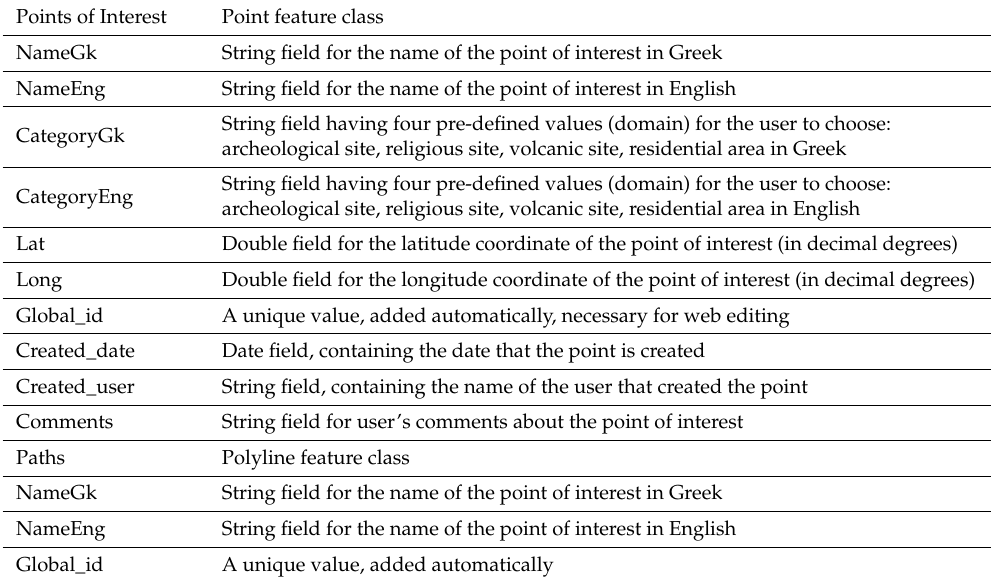
Table 2. File Geodatabase schema for data